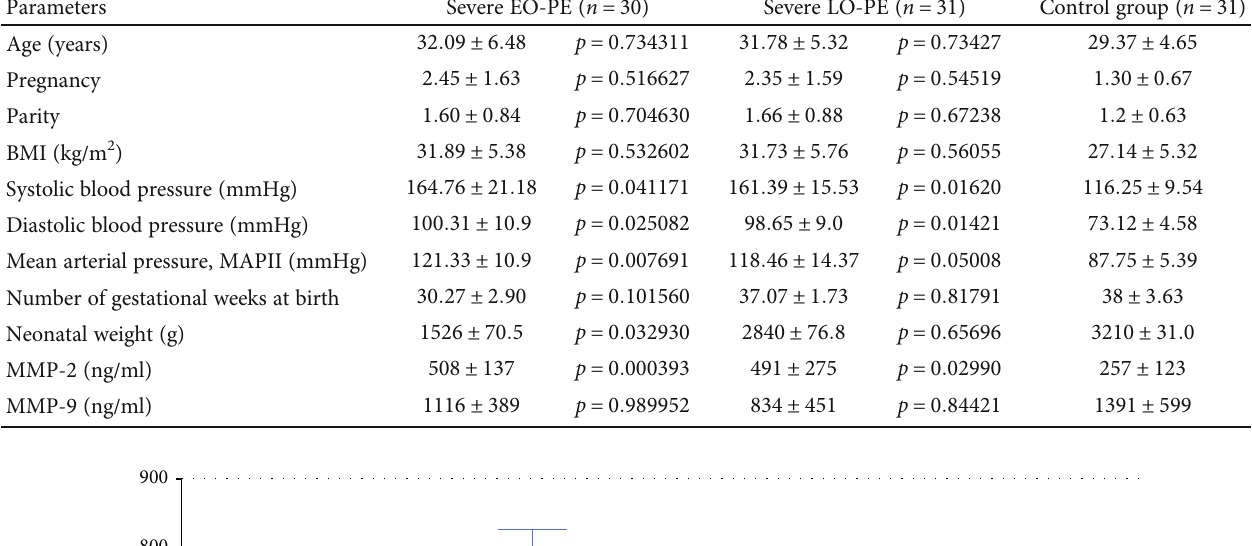
Table 1: Clinical characteristics of EO-PE and LO-PE patients and control subjects.